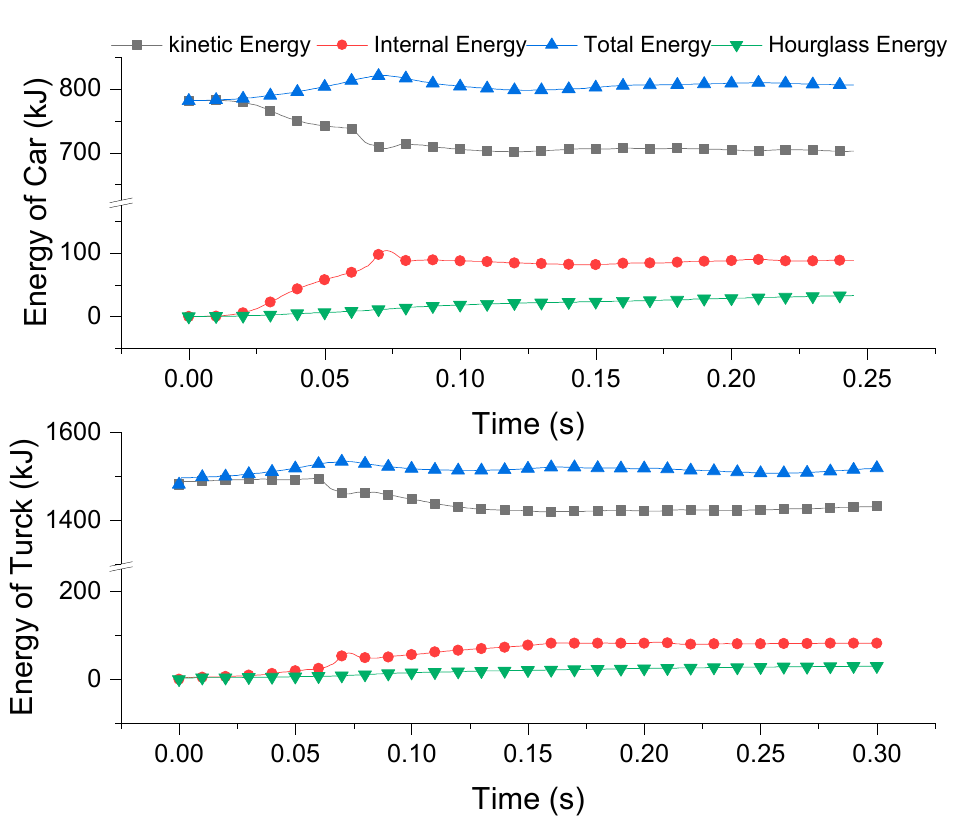
Figure 10. The energy–time relationship of the vehicle–ground–guardrail system.